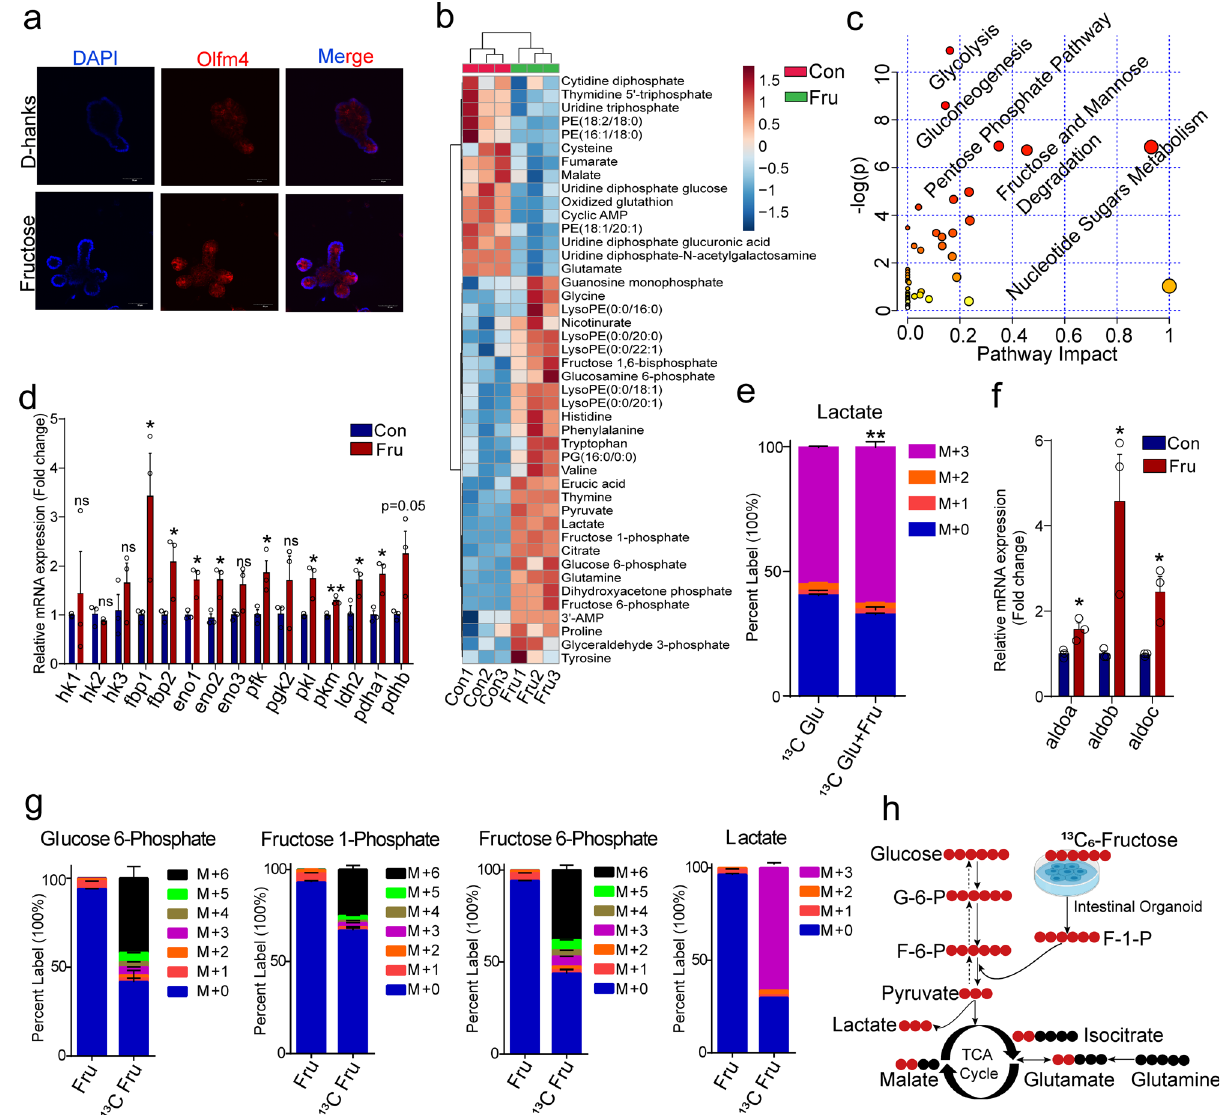
Fig. 6 Fructose metabolism drives ISC proliferation by engaging glycolysis. a Representative immuno fl uorescent images of Olfm4 (Red) in intestinal organoids treated with or without fructose. Nuclei are stained blue. Scale bar, 50 μ m. Images are representative of n = 3 biologically independent samples. b Heatmap showing a differential metabolic pro fi le of fructose (10 mM)-treated intestinal organoids for 24 h. c Pathway enrichment analysis of differential metabolites from intestinal organoids treated with fructose (10 mM) as compared to PBS-treated controls by using Ingenuity Pathway Analysis (IPA). Red circles denote pathways that have signi fi cant changes. d Relative mRNA expression of key enzymes involved in glycolysis. hk , hexokinase; fbp , fructose- bisphosphatase; eno , enolase; pfk , phosphofructokinase; pgk , phosphoglycerate kinase; pk , pyruvate kinase; ldh , lactate dehydrogenase; pdh : pyruvate dehydrogenase complex. Data are expressed as mean fold change ± SEM for n = 3, unpaired two-tailed Student ’ s t -test ( p = 0.05 for fbp1 ; p = 0.04 for fbp2 ; p = 0.01 for eno1 ; p = 0.01 for eno2 ; p = 0.08 for eno3 ; p = 0.03 for pfk ; p = 0.02 for pkl ; p = 0.001 for pkm ; p = 0.04 for idh2 ; p = 0.01 for pdha1 ; p = 0.05 for pdhb ). e Percent labeling of lactate following treatment of intestinal organoids with 10 mM U-[ 13 C]-Glucose ( 13 C Glu) after 24 h treatment with 10 mM fructose (Fru). The # in the (M + #) designation indicated how many [ 12 C] were replaced with [ 13 C] in the isotopic labeled metabolites. The abundance is expressed as percent labeling among all isotopomers of the metabolites. Data are expressed as mean ± SEM for n = 3, unpaired two-tailed Student ’ s t -test, ** p < 0.01 for (M + 3) lactate. f Relative mRNA expression of aldonase isoforms involved in fructose utilization. aldo , aldolase. Data are expressed as mean fold change ± SEM for n = 3, unpaired two-tailed Student ’ s t -test ( p = 0.03 for aldoa : p = 0.02 for aldob ; p = 0.01 for aldoc ). g Percent labeling of the indicated metabolites following treatment of mature intestinal organoids with 10 mM U-[ 13 C]-Fructose ( 13 C Fru) for 6 h. Data are represented as mean ± SEM for n = 3. h Schematic summary of the conversion of [ 13 C]-fructose into key metabolites in glycolysis, tricarboxylic acid (TCA) cycle, and glutamine metabolism pathway as found in intestinal organoids.